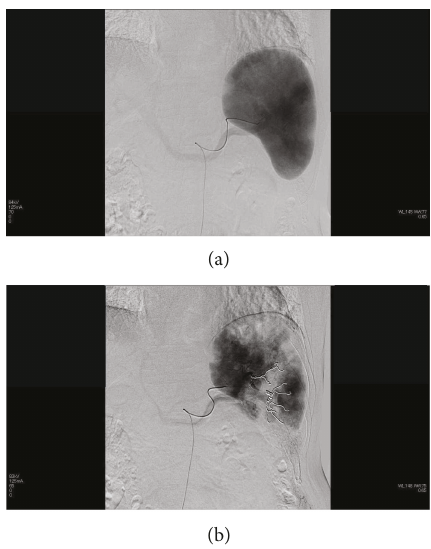
Figure 1: Procedure for partial splenic embolization. The catheter was advanced to the hilum of the splenic artery. Branches of splenic arteries were embolized with microcoils and pieces of gelatin sponge, targeting about 60% embolization.